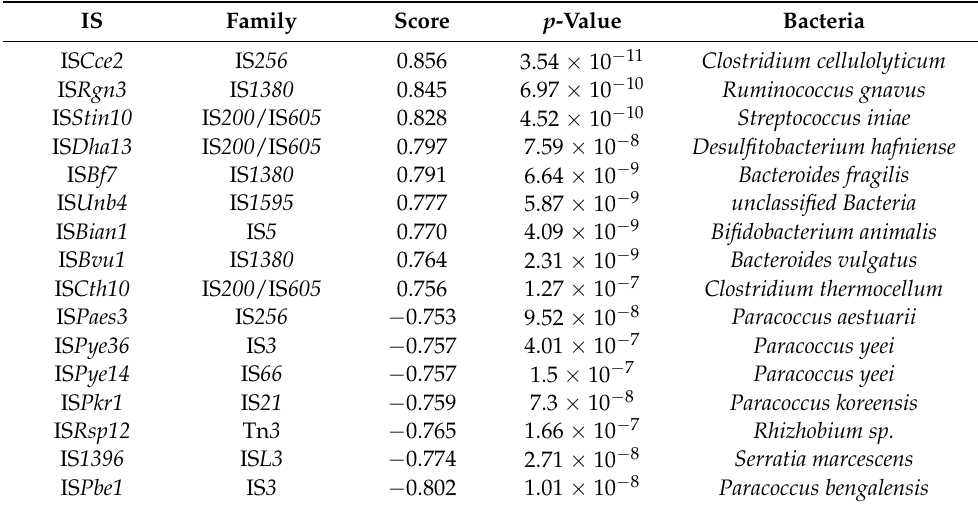
Table 1. Correlations involving the tetW gene in the dairy cow dataset.